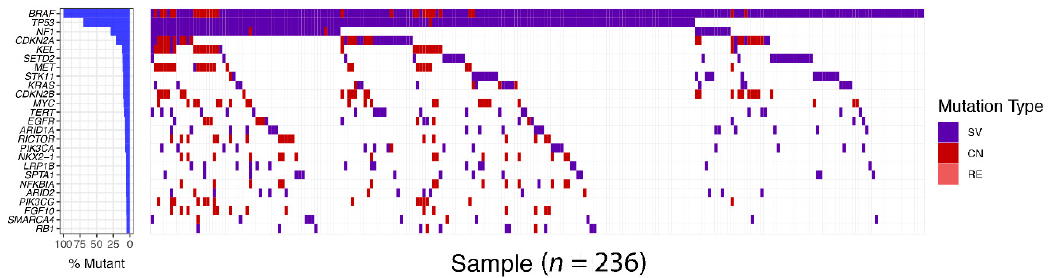
Figure 4. BRAF alterations concurrent with other genetic aberrations in non-small cell lung cancer (NSCLC). Targeted tumor exome sequencing using 403 cancer gene panel was performed by Foundation medicine. In all, 236 samples with BRAF alterations, such as structural variation (SV), copy number variation (CV), and rearrangement (RE), were stratified from 30,000 non-small cell lung cancer samples. Oncoprint of BRAF-mutant tumor shows coexistence of other genetic alterations with BRAF gene alteration. The different frequency of gene alterations is indicated on the left bar plot.